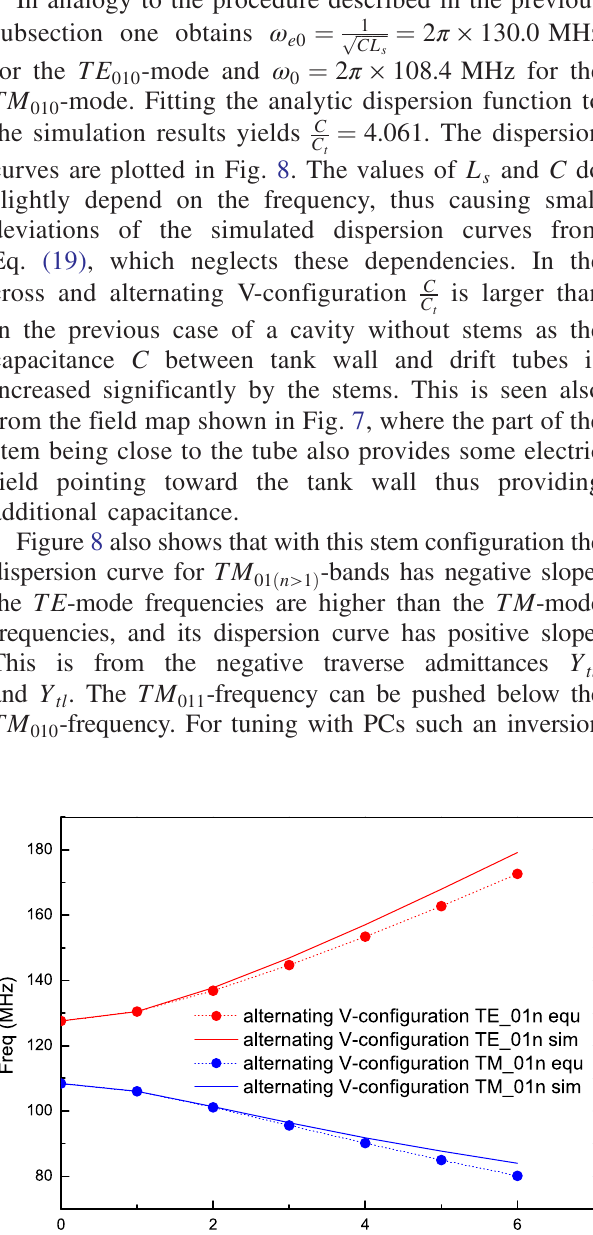
FIG. 9. Field and current pattern for two different TE -modes with constant V-configuration. (a): resonator between tube and upper part of the tank with the basic frequency of 149.2 MHz. (b): resonator between tube and lower part of the tank with the basic frequency of 65.0 MHz. (c): current pattern for case